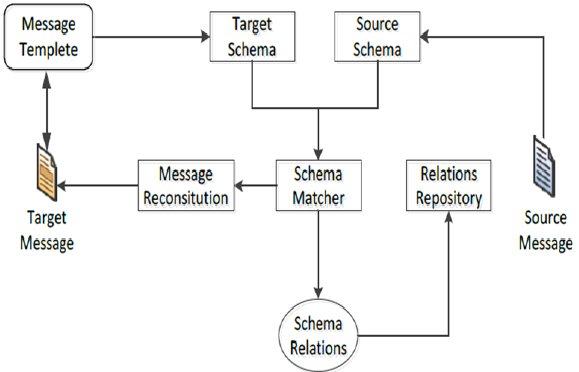
Figure 9. Process of message transformation and